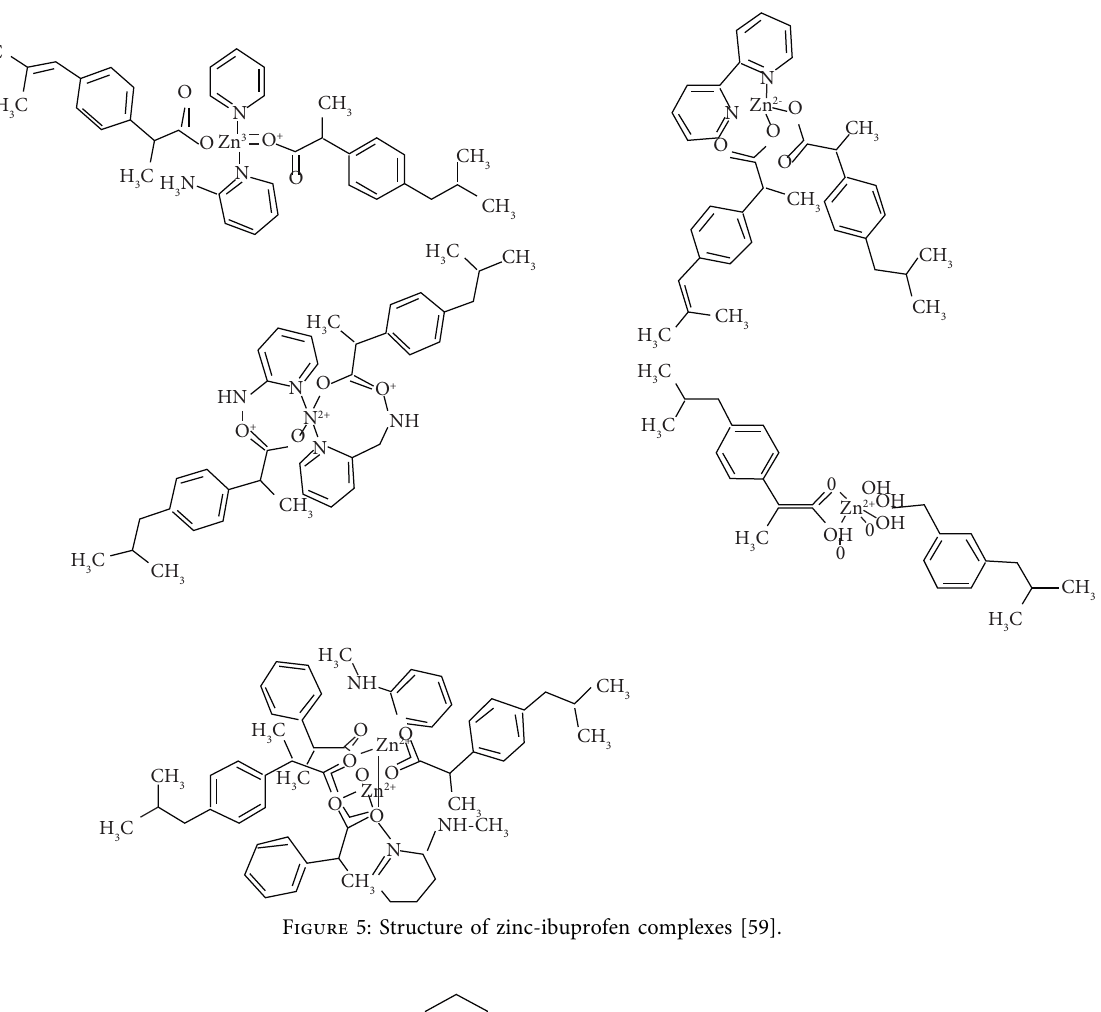
Figure 5: Structure of zinc-ibuprofen complexes [59].